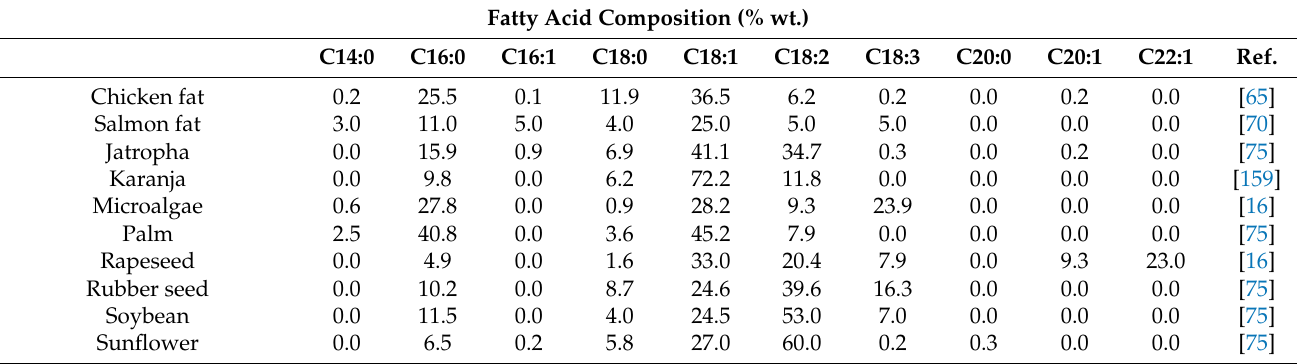
Table 3. Fatty acid composition of some edible and non-edible biomasses; data adapted from sources in the “Ref.” column. C x : y is a fatty acid with x carbon atoms and y unsaturations. Fatty Acid Composition (%